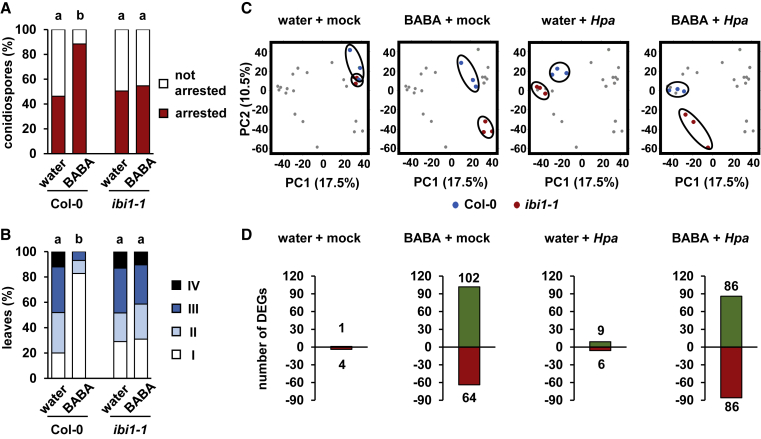
Global Transcriptome Analysis of Wild-Type Arabidopsis (Col-0) and the BABA Receptor Mutant ibi1-1.Three-week-old plants were soil-drenched with water or BABA (10 mg/l) and challenged with conidiospores of Hyaloperonospora arabidopsidis (Hpa) 2 days later. Replicate shoot samples for RNA extraction and analysis of callose deposition were collected at 2 dpi. Samples for the analysis of Hpa colonization were collected at 5 dpi.(A) Quantification of the effectiveness of callose depositions in arresting Hpa colonization at the epidermal cell layer. Hpa-induced callose was analyzed in aniline blue/calcofluor-stained leaves by epifluorescence microscopy. Shown are percentages of callose-arrested and non-arrested conidiospores (see Supplemental Figure 7 for details). Different letters indicate statistically significant differences in class distribution between samples (Fisher's exact tests + FDR; p < 0.05; n = 110–130 conidiospores).(B) BABA-induced resistance (BABA-IR) against Hpa. Pathogen colonization was determined by microscopy analysis of trypan blue-stained leaves. Leaves were assigned to different Hpa colonization classes (I: no growth; II: hyphal growth; III: hyphal growth + conidiophores; IV: extensive hyphal growth + conidiophores + oospores; see Supplemental Figure 6 for details). Different letters indicate statistically significant differences in class distribution between samples (Fisher's exact tests + FDR; p < 0.05; n = 25–30 leaves).(C) Principal component analysis (PCA) of relative gene expression values (Arabidopsis Gene ST 1.1 array). Biologically replicated samples (n = 3) from Col-0 (blue) and ibi1-1 (red) are highlighted within the same PCA plot for each of the four experimental conditions (water + mock, BABA + mock, water + Hpa, and BABA + Hpa).(D) Numbers of differentially expressed genes (DEGs) between Col-0 and ibi1-1 under the four different (pre-)treatment conditions (linear model + FDR; q < 0.01). Red bars indicate downregulated DEGs in ibi1-1; green bars indicate upregulated DEGs in ibi1-1.